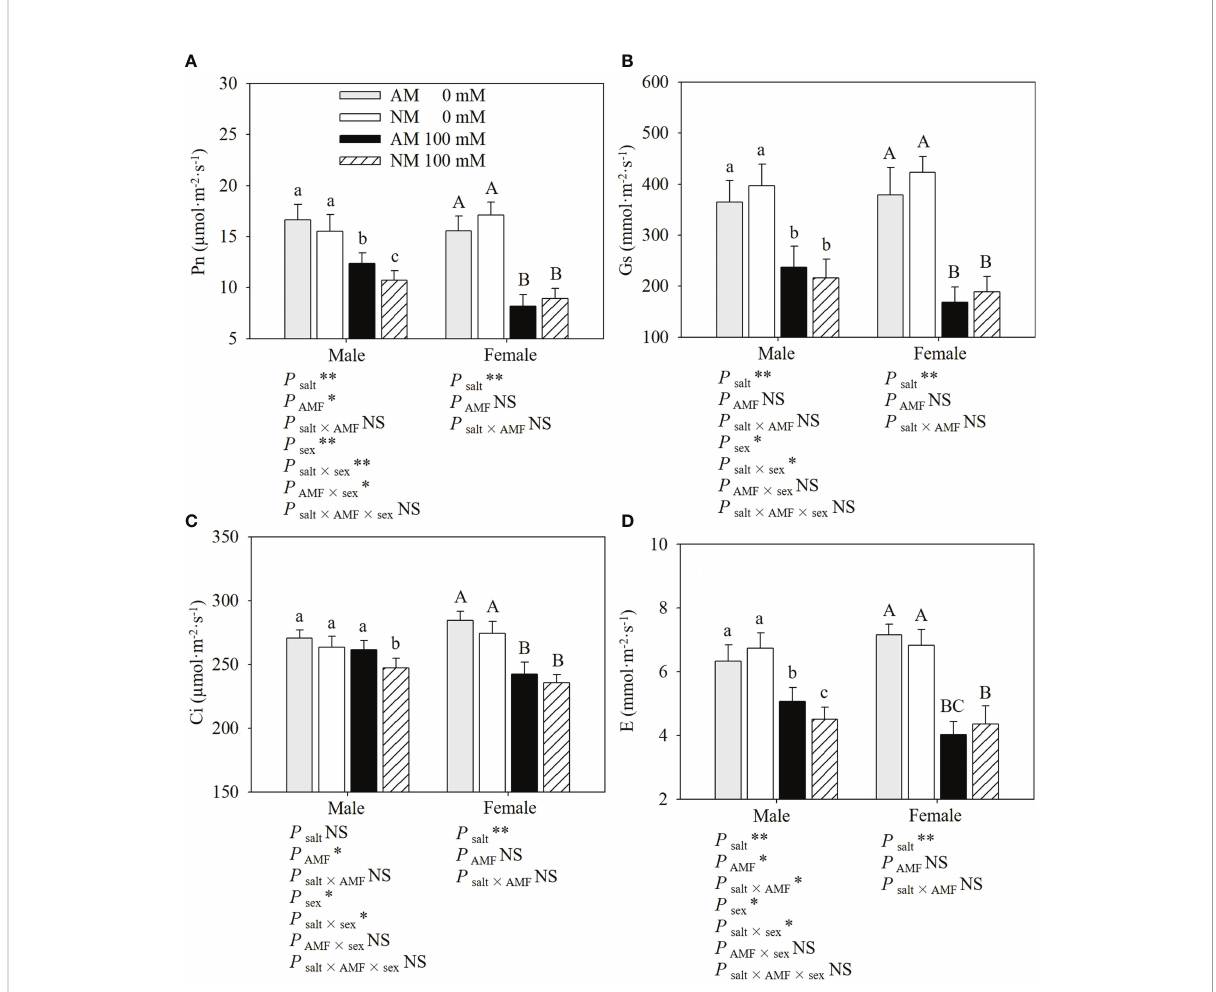
FIGURE 1 Effects of AMF inoculation on Pn (A) , Gs (B) , Ci (C) and E (D) of P. euphratica males and females under different salt conditions AM, AMF inoculation; NM, non-inoculation; 0 mM, without salt stress; 100 mM, under salt stress; AMF, AMF formation; **: signi fi cant effect at P ≤ 0.01; *: signi fi cant effect at 0.01 < P ≤ 0.05; NS, no signi fi cant effect. Different letters (lowercases for males and capital letters for females) indicate signi fi cant difference at P ≤ 0.05, the data are means ± SD (n =